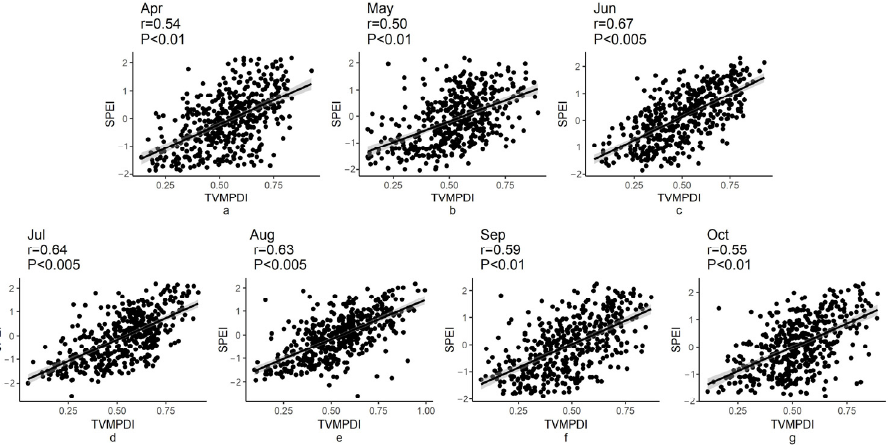
Figure 2. Scatter plot of the TVMPDI and SPEI at the meteorological station from April to October: ( a ) April; ( b ) May; ( c ) June; ( d ) July; ( e ) August; ( f ) September; ( g ) October.